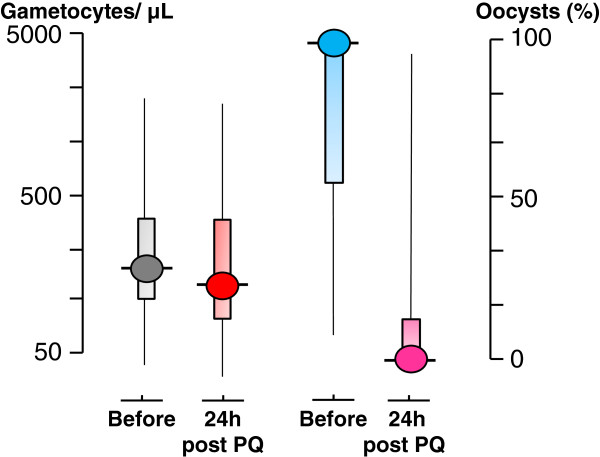
The rapid sterilizing effect of primaquine in falciparum malaria; studies of mosquito infectivity following anti-malarial treatments of falciparum malaria with plasmoquine or primaquine in which oocyst assessments were made in mosquitoes which fed 24 hours after drug administration. Oocysts were assessed typically in 10–20 mosquitoes 6–7 days after feeding Medians (IQR) and ranges shown. Gametocytaemia changed little in 24 hours (although it usually fell rapidly thereafter) (left side) (N=51), whereas oocyst numbers fell rapidly and were not found at all in the majority of mosquito batches fed on treated patients (right side) (N=79). When the fed mosquitoes were evaluated later sporozoites were correspondingly absent)
[15].